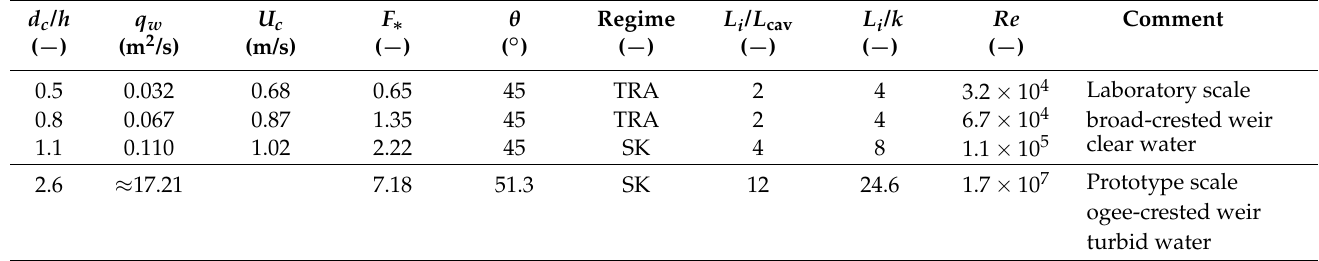
Table 1. Present flow conditions; note that intrusive phase-detection probe measurements for d c / h = 0.5 and 0.8 were presented in Kramer and Chanson [29]; TRA = transition flow; SK = skimming